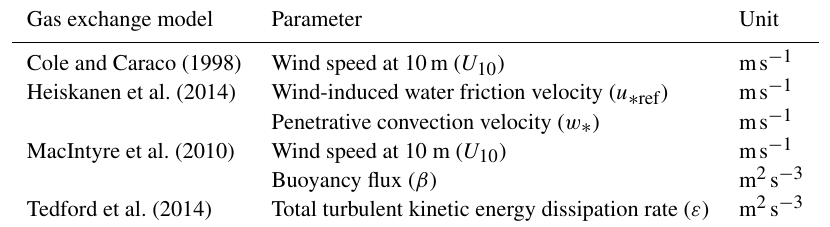
Table 1. Parameters used in the parameterizations of the gas transfer velocity in the gas exchange models by Cole and Caraco (1998), Heiskanen et al. (2014), MacIntyre et al. (2010), and Tedford et al. (2014). Gas exchange model Parameter Unit Cole and Caraco (1998) Wind speed at 10m ( U 10 ) ms − 1 Heiskanen et al. (2014) Wind-induced water friction velocity ( u ∗ ref ) ms − 1 Penetrative convection velocity ( w ∗ ) ms − 1 MacIntyre et al. (2010) Wind speed at 10 m ( U 10 ) ms − 1 Buoyancy flux ( β ) m 2 s − 3 Tedford et al. (2014) Total turbulent kinetic energy dissipation rate ( ε ) m 2 s −